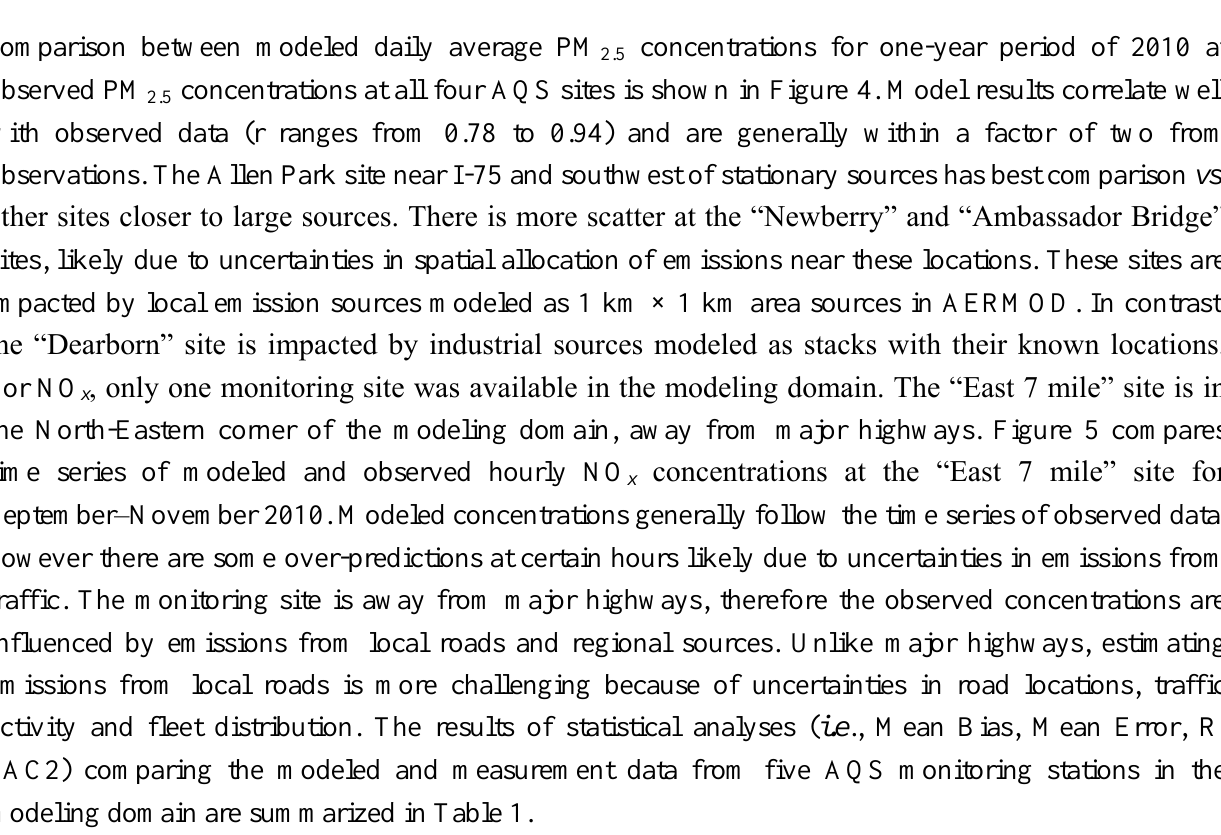
Figure 3. Locations of PM , black carbon (BC) and NO monitors at NEXUS (●, ▲) and 2.5 x AQS sites (■). (Notes: Colors of symbols denote roadway classification as described in Figure 1; numbers next to the NEXUS site locations indicate measurement site